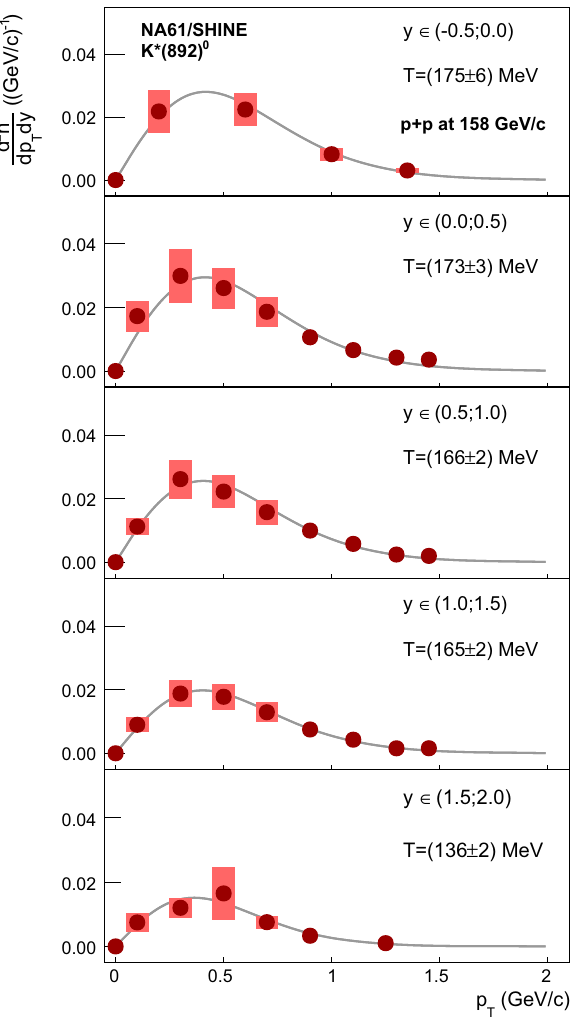
Fig. 11 Transverse mass spectra 1 for five bins of rapidity. The numerical values are listed in Table 4. The solid lines represent dydp T function given by Eqs. (12) and (13) with A and T parameters taken from Fig. 10